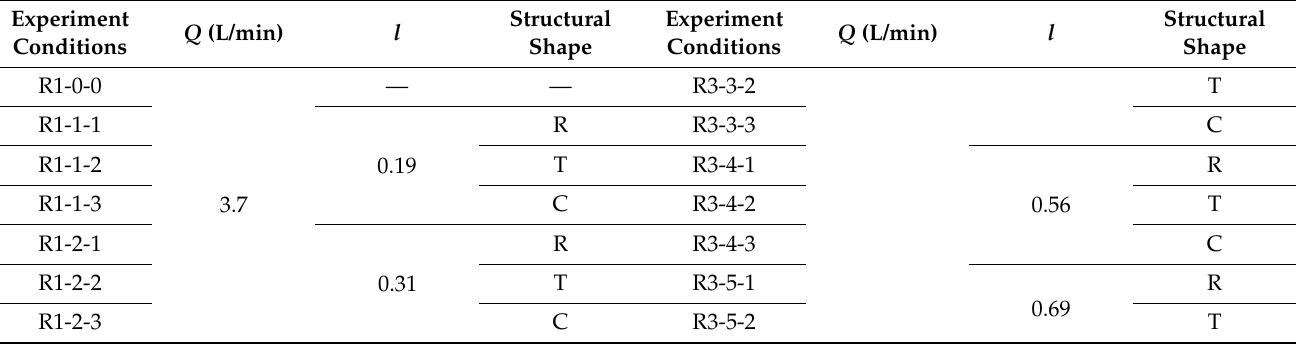
Table 1. Experimental conditions (C for semi-cylinder, R for rectangular column; T for triangular